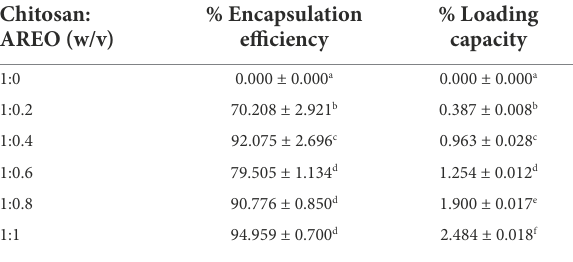
TABLE 2 Effect of different concentrations of AREO on encapsulation efficiency and loading capacity. Chitosan: AREO